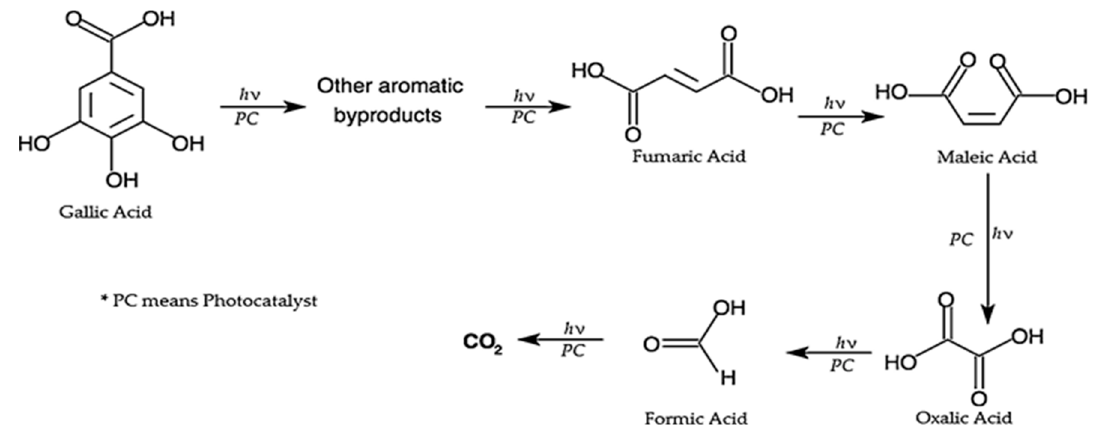
Figure 8. Proposed mechanism for the photocatalytic degradation of gallic acid reproduced from [67], with permission from Elsevier, 2016.